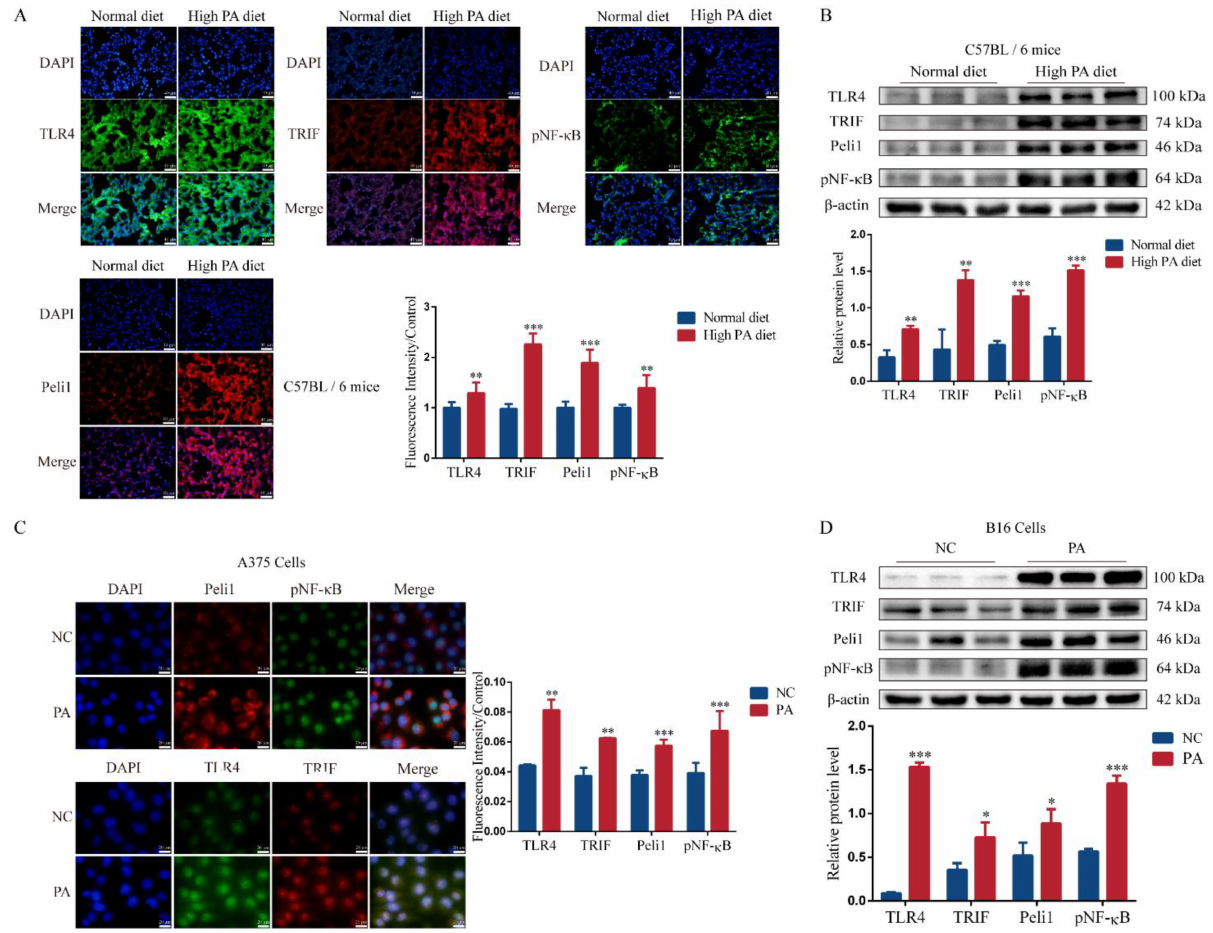
Figure 3. PA activated the TLR4/TRIF-Peli1-pNF- κ B pathway in melanomas. ( A ) The fluorescence intensity and quantitative analysis of TLR4, TRIF, Peli1, and pNF- κ B in mice lung tissues. ( B ) The blots of protein and quantitative analysis of mice lung tissues. ( C ) The fluorescence intensity and quantitative analysis of TLR4, TRIF, Peli1, and pNF- κ B in A375 cells. ( D ) The blots of protein and quantitative analysis of B16 after PA treatment for 24 h. * p < 0.05, ** p < 0.01, or *** p < 0.001 compared with the control